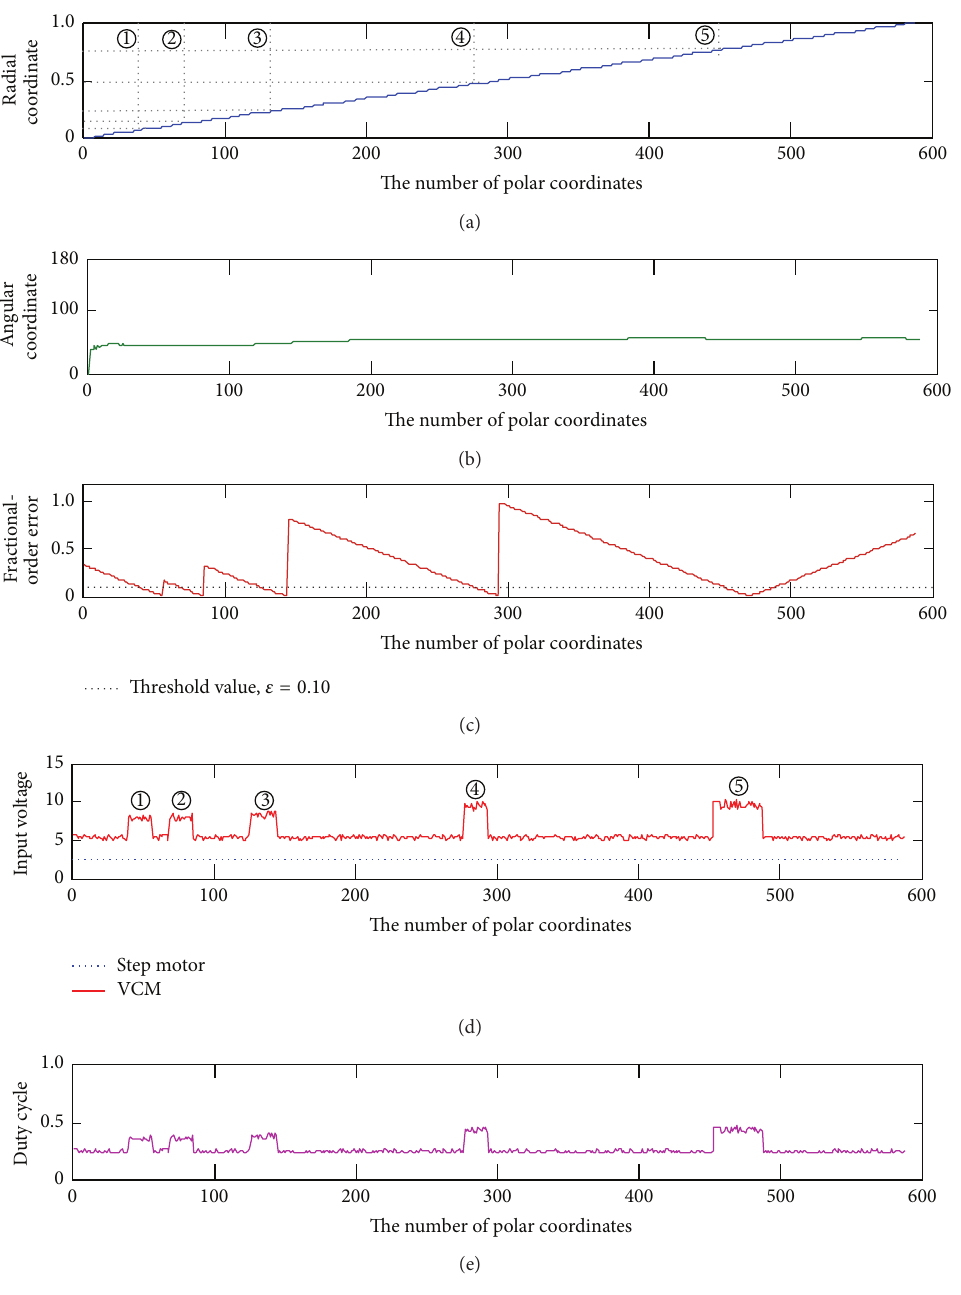
Figure 9: (a) Radial coordinates of the blood vessel and tortuous sites ( A → E ), (b) angular coordinates of the blood vessel, (c) tracking evaluations with the fractional-order errors, (d) varying input voltages with the PWM control, and (e) varying duty cycles with the buck-boost